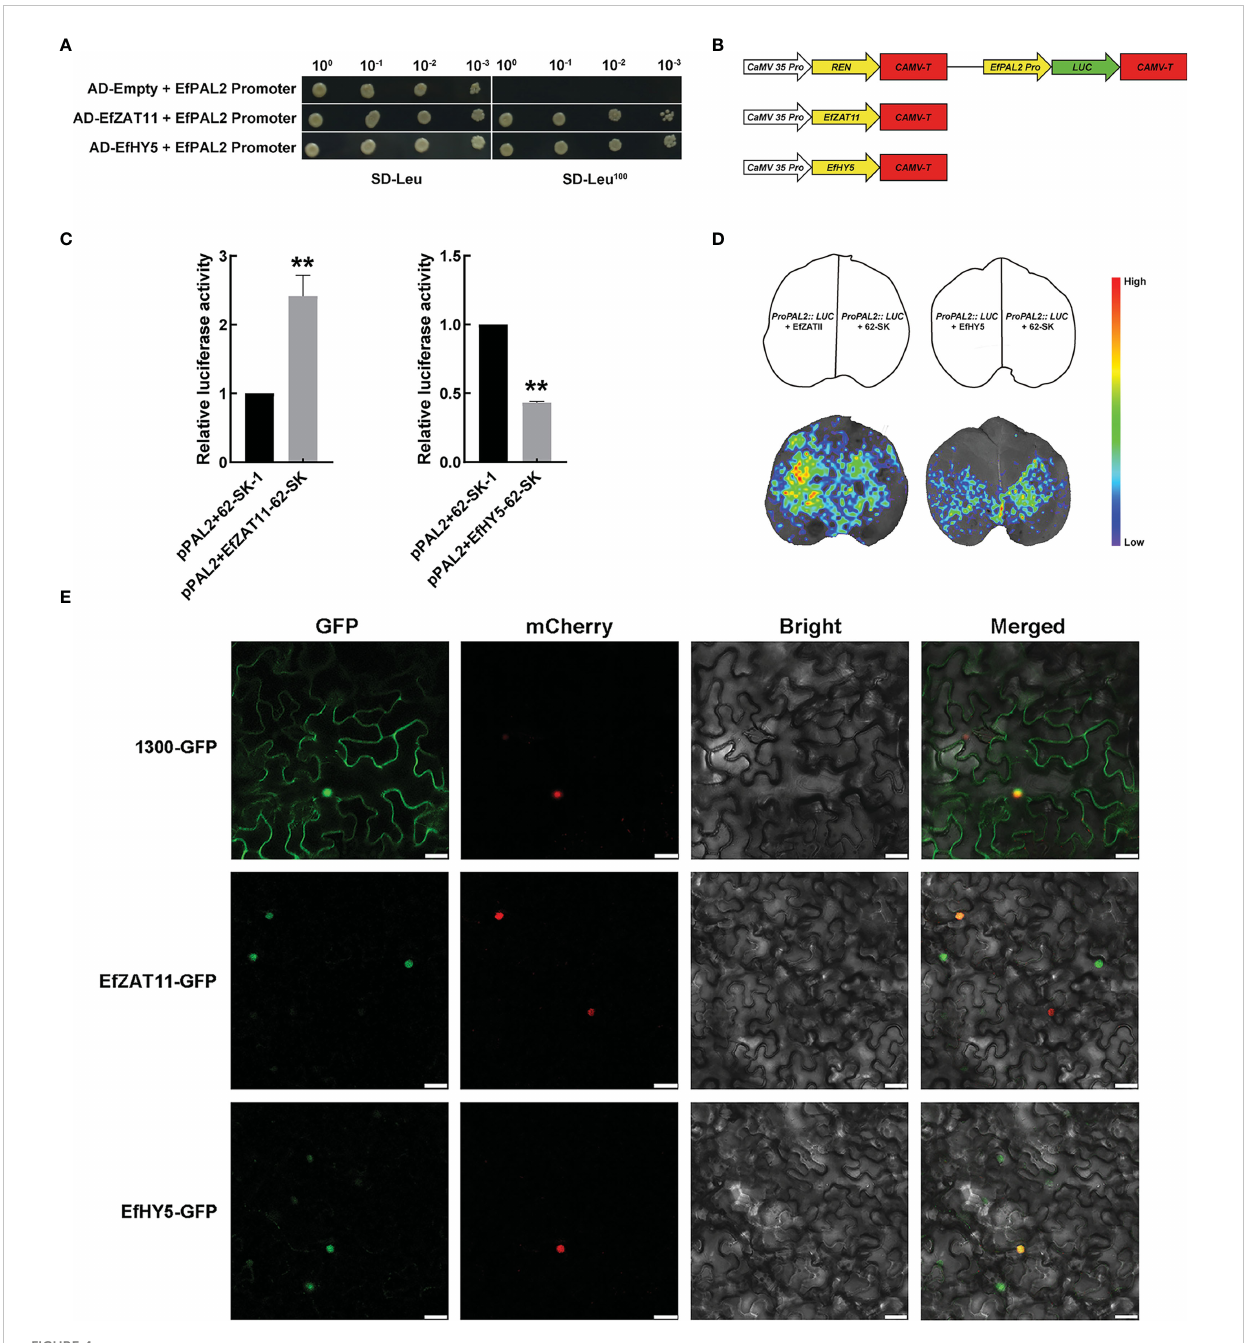
FIGURE 4 EfZAT11 and EfHY5 bind directly to the promoter of EfPAL2 to regulate the expression of EfPAL2 and subcellular localization. (A) Physical interactions between EfZAT11, EfHY5 and EfPAL2 promoter were veri fi ed by Y1H. (B) Schematics of transient expression vectors. REN: Rinilla luciferase (C) Transient dual-luciferase detections of ProPAL2 in N. benthamiana leaves. (D) CCD image of luciferase (LUC) reporters in (C) . (E) Subcellular localization of EfZAT11 and EfHY5 in the N. benthamiana leaves, Bar=30 m m. The ‘ * ’ or ‘ ** ’ above the histogram indicated the statistical signi fi cance at the level of 0.05 or 0.01(p < 0.05; p < 0.01). Error bars show SD from three biological